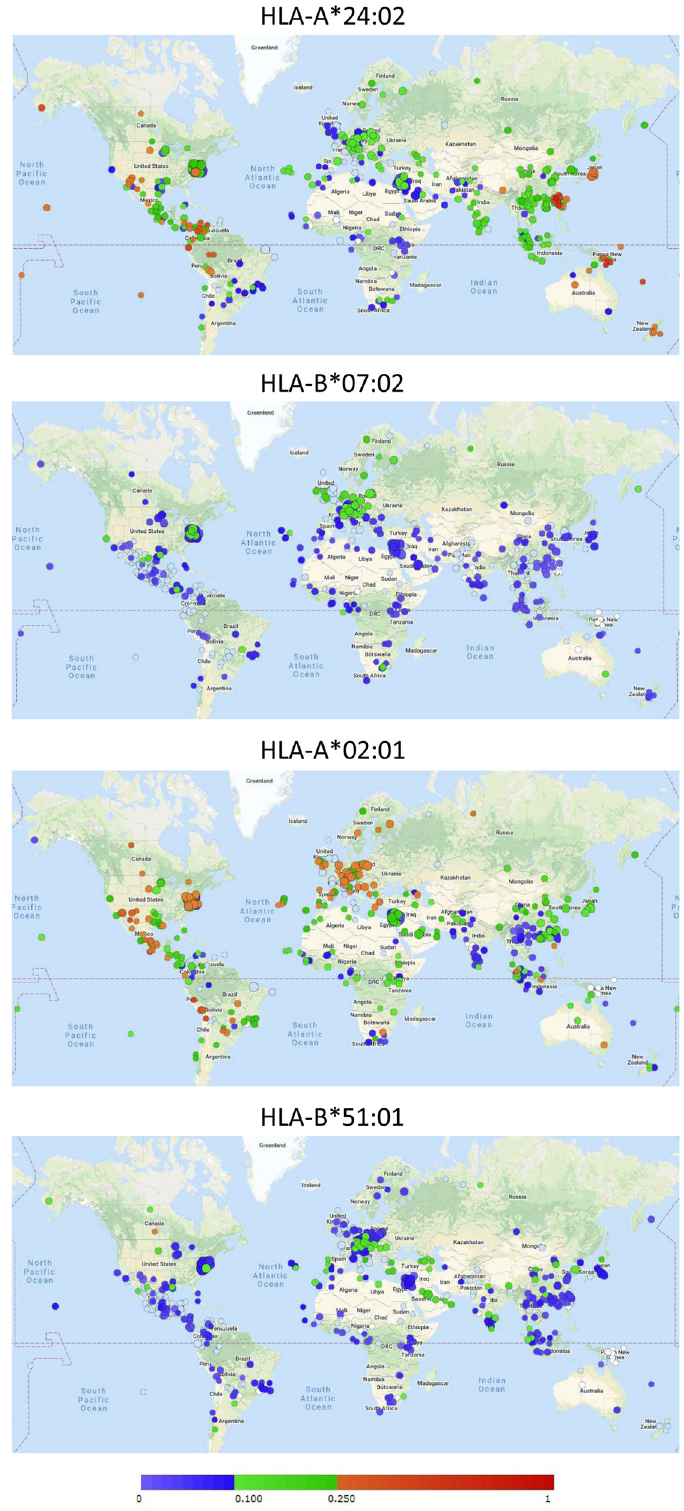
Figure 3. Global distribution of HLA-A*24:02, HLA-B*07:02, HLA-A*02:01, and HLA-B*51:01 allele frequencies as visually summarized by the Allele Frequency Net Database (Gonzalez-Galarza et al. , 2020). Circles refer to individual studies with the color indicating the detected allele frequency following the color bar. See http://www.allelefrequencies.net / for more detailed information on those studies. Permission to reproduce this image was obtained from AFND.